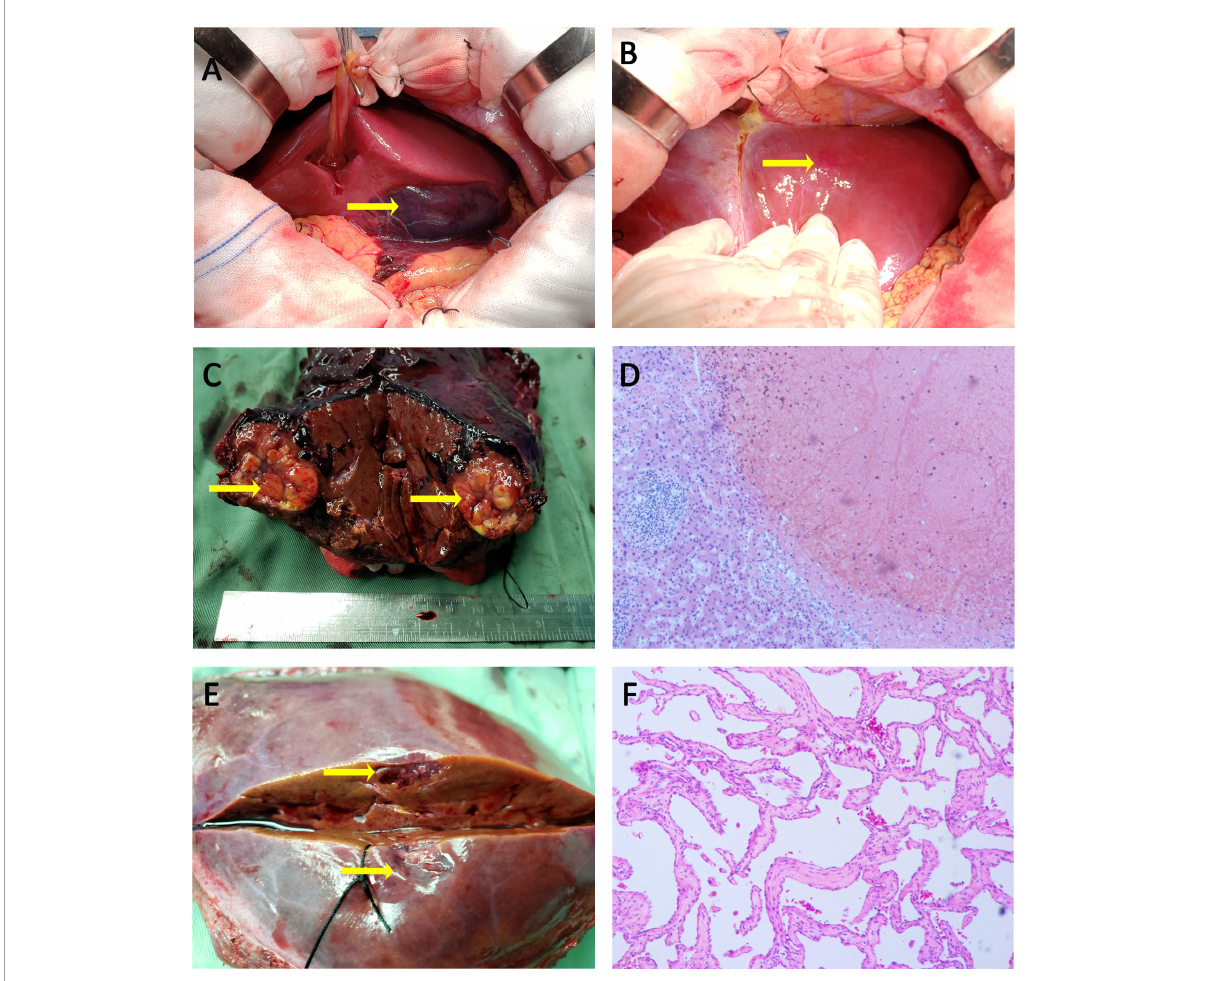
FIGURE3 Intraoperative photographs, specimen photographs and Pathological examination. (A) A subcapsular hemotoma with a marked laceration was found on the visceral surface of the left hepatic lobe. (B) A hepatic hemangioma was observed on the surface of segment II. (C) Surgical specimen demonstrated a rounded, grayish-yellow, and non-encapsulated nodule with well-defined margins under hemotoma. (D) The lesion under hepatic hemotoma was SNNL,characterized as the central necrotic tissue surrounded by a fibrous capsule containing inflammatory cells (H&E, × 100). (E) The appearance of cross-sectional surface for lesion in segment II was grayish-brown. (F) The lesion in segment II was demonstrated to be hepatic hemangioma (H&E, ×